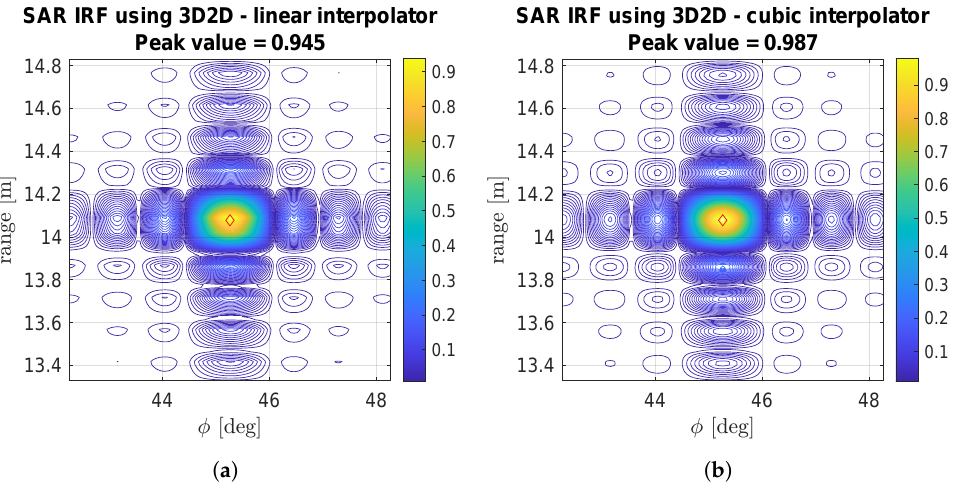
Figure 11. A s = 18 cm. SAR Impulse Response Function (IRF) generated by 3D2D on a very fine polar grid centered in the nominal position of the target. The higher the order of the interpolator, the better the image in terms of peak value and